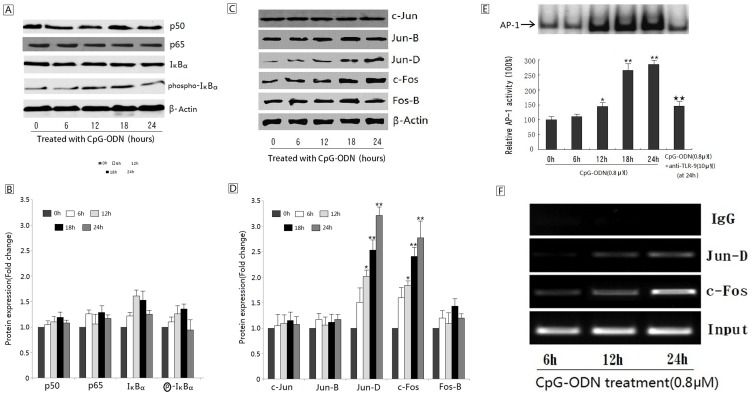
Effect of CpG-ODN on NF- κB and AP-1 activity.(A) Effects of CpG-ODN on the expression of NF- κB subunit. HB cells were treated with 0.8 μM CpG-ODN at indicated time period (0∼24 h) and the protein levels were determined using Western blot. β-actin was used as an internal control. (B) Changes in NF- κB subunit protein levels compared with the control as determined by densitometric scanning of the immunoreactive bands. (C) Effects of CpG-ODN on the expression of AP-1 subunit. (D) Changes in AP-1 subunit protein levels compared with control as determined by densitometric scanning of the immunoreactive bands. (*P<0.05; **P<0.01, compare with the control) (E) Electrophoretic mobility shift analysis (EMSA) analysis of AP-1 in HB cell lines before and after treatment with 0.8 μM CpG-ODN at indicated time period (0∼24 h). (*P<0.05; **P<0.01, compared with the panel 1), (★★P<0.01, compared with the panel 5). (F) CpG-ODN treatment enhances the DNA-binding activity of AP-1(c-Fos/Jun-D) to the promoter of MMP-2 in a time-dependent manner.